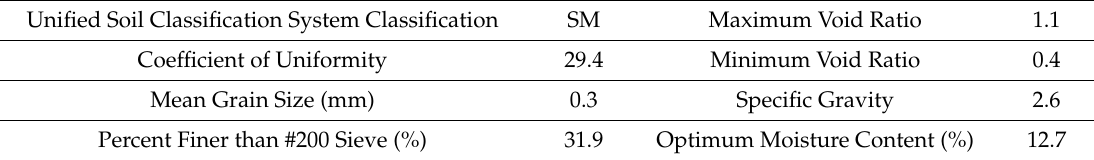
Table 2. Properties of Gwanak